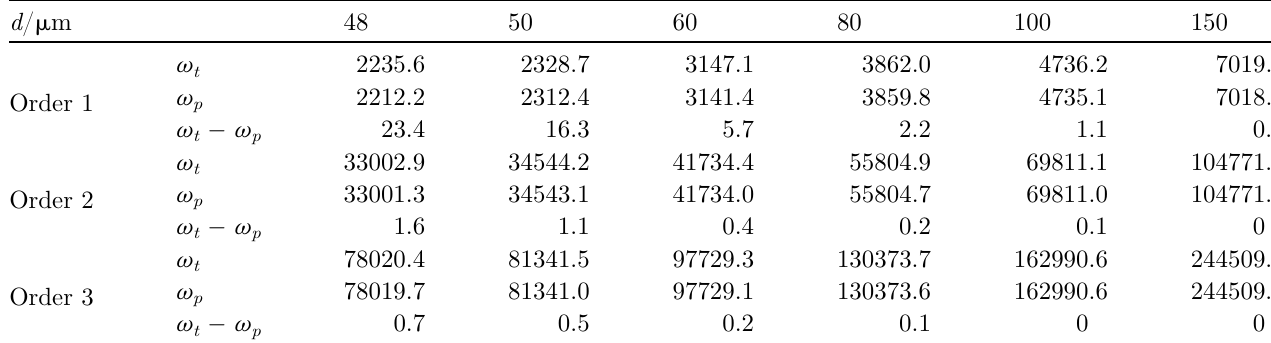
Table 11. Changes of natural frequency with d with and without damping (rad/s).